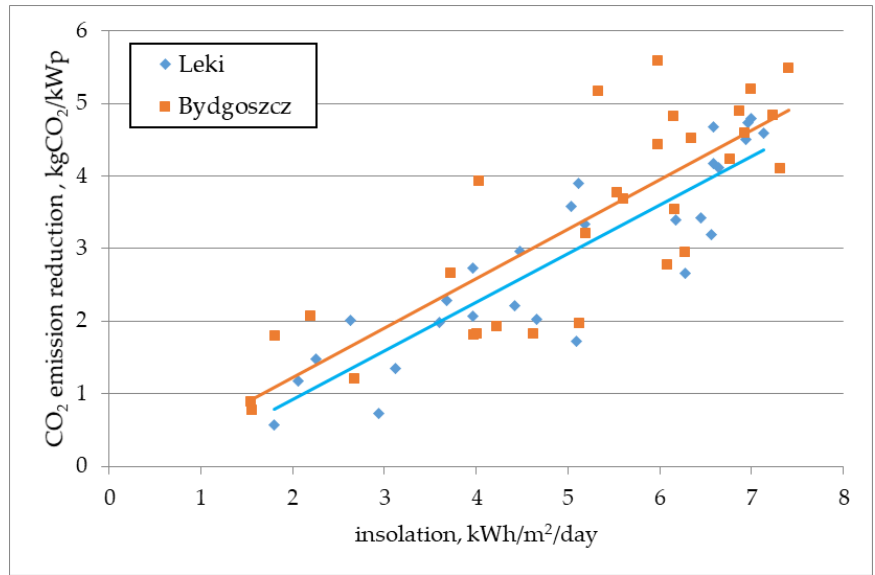
Figure 18. Daily reduction of CO 2 emissions as a function of insolation.